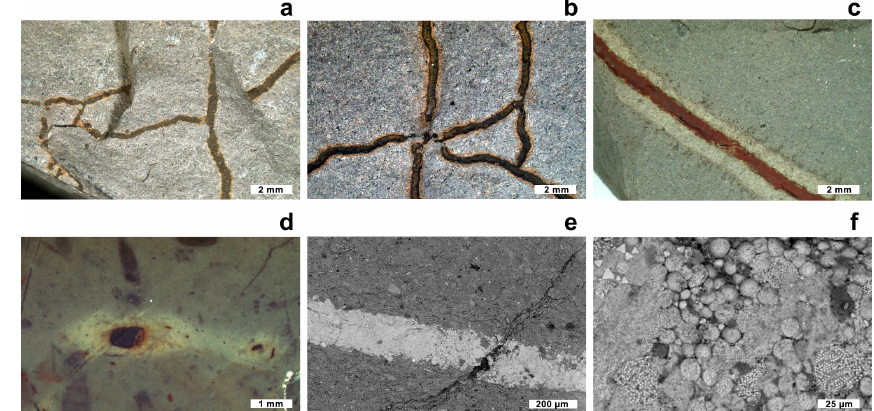
Figure 1. Macro- and microimages of Trichichnus in the rock fractures and slabs: (a–c) Albian turbiditic marly mudstones, Kozy, Pol- ish Carpathians; (d) Valanginian–Hauterivian pelagic marlstones. Dolina Ko´scieliska valley, Tatra Mountains, Poland (e) , (f) Eocene silty shales, Zbludza, Polish Carpathians. (a) – (b) Subhorizontal network of Trichichnus . (c) – (d) Halo (diffusion zone of iron (oxi)hydroxides) around horizontal (c) and vertical (d) Trichichnus . (e) Infilling of a fragment of Trichichnus with abundant pyrite framboids and iron (oxi)hydroxides (SEM BSE). (f) Magnification of image (e) . Specimen numbers: (a) INGUJ147P70, (b) INGUJ147P71, (c) INGUJ147P72,